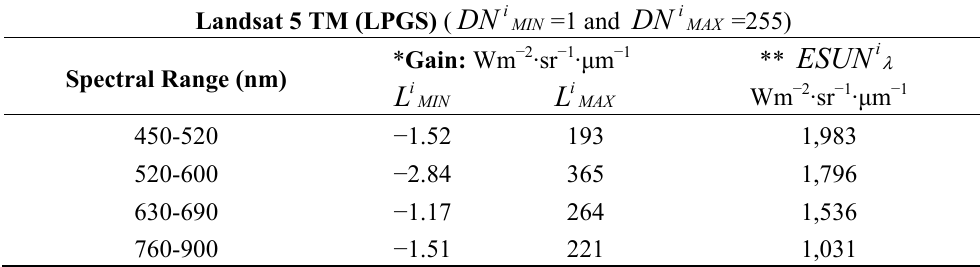
Table 4. Landsat 5 TM spectral ranges, gains ( MAXi L and MINi L ), and mean exo-atmospheric solar irradiances ( λ i ESUN ) for cassava and